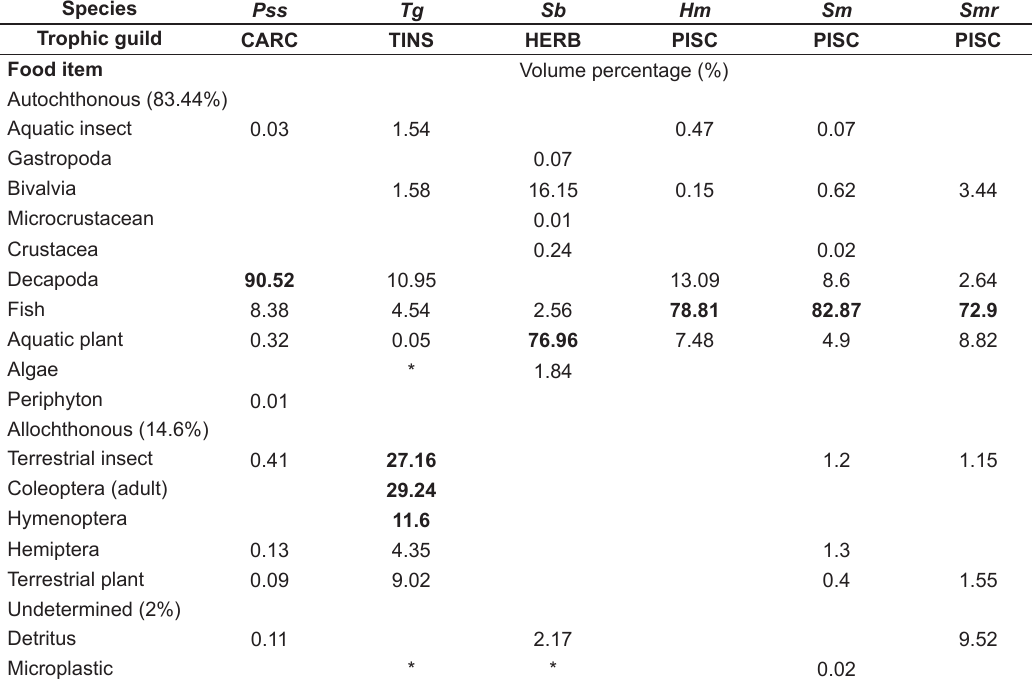
* 0.02 CARC = Carcinophage, TINS = Terrestrial insectivore, HERB = Herbivore, PISC = Piscivore. *Percentage